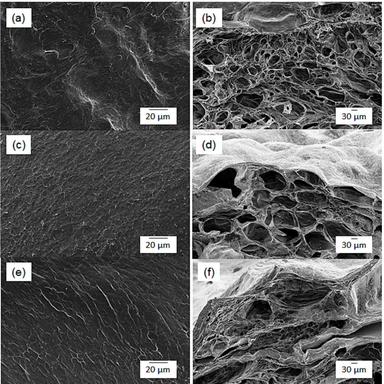
Images of top surface and cross section of KGM (a and b), KGM/CNC (c and d) and KGM/CNC-Ag (e and f) membranes.